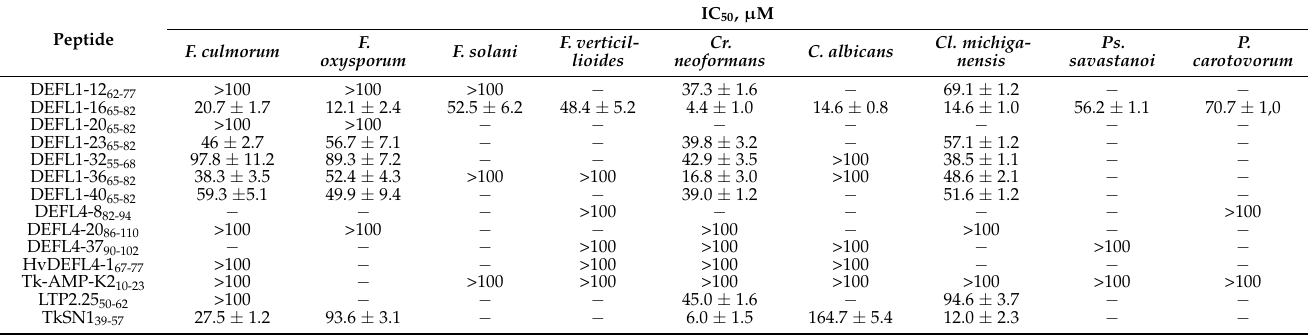
Table 2. Antimicrobial activity of γ -core motif